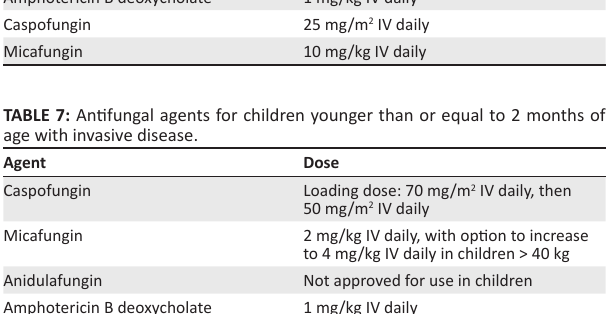
TABLE 6: Antifungal agents for children younger than 2 months of age with invasive disease. Agent